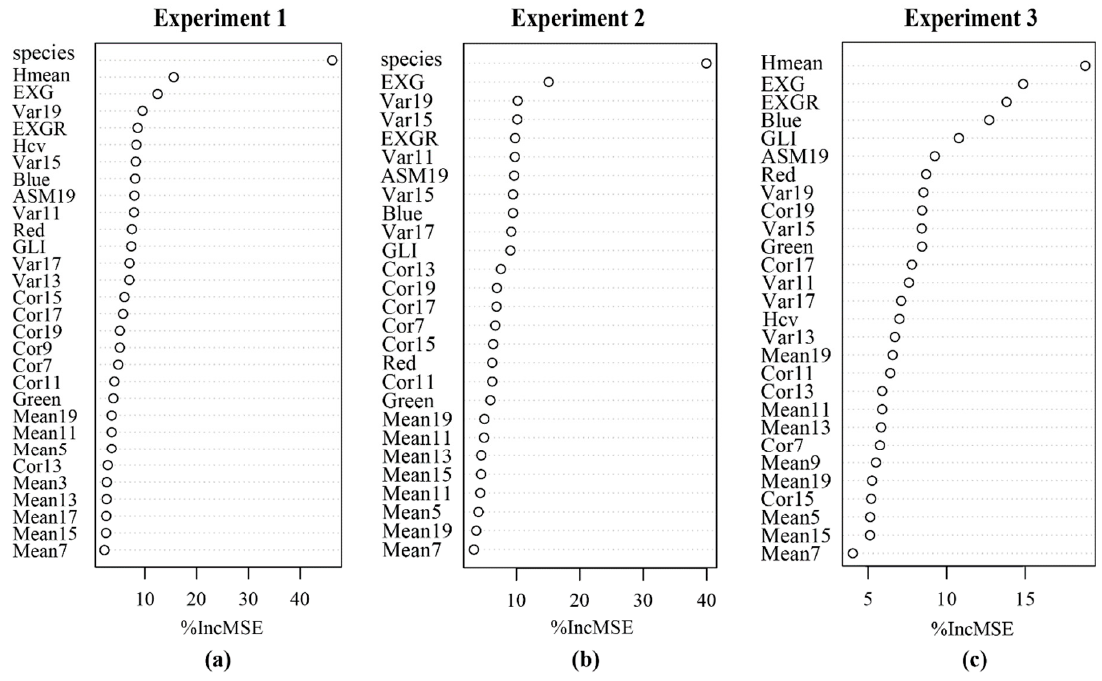
Figure 5. Selected variables of each experiment and their importance values ( a - c ).